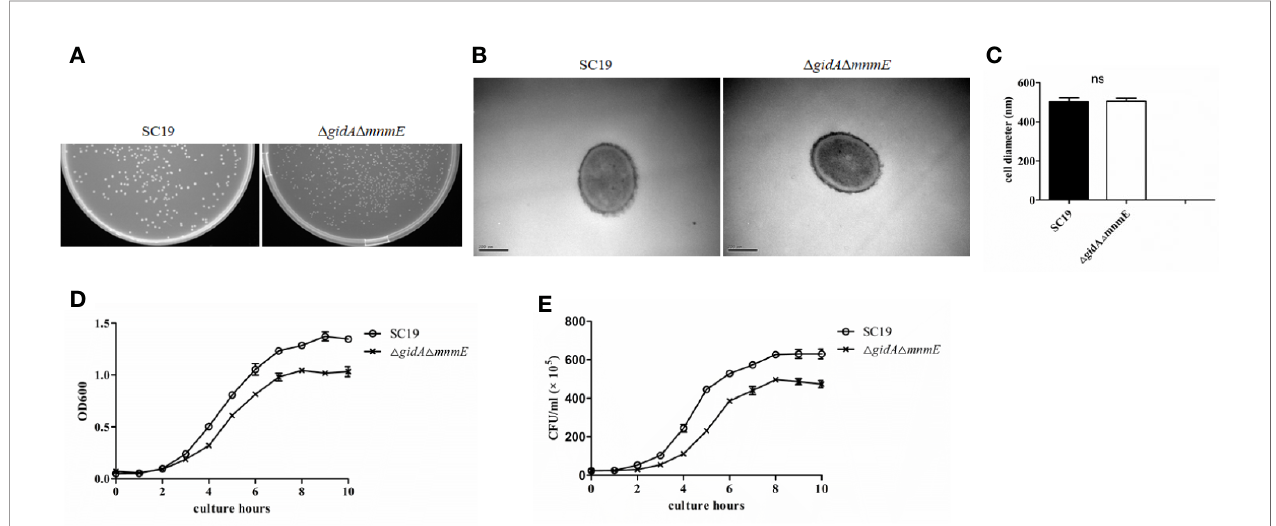
FIGURE 3 | Micrographs and growth characterization of SC19 and D gidA D mnmE . (A) Colonies of SC19 and D gidA D mnmE cultured overnight on THA plates. (B) Transmission electron microscopy micrographs of the strains. (C) Quanti fi cation of transmission electron microscopy (TEM) analysis of cell size. (D) Growth curves of the strains. Bacterial cell density was measured spectrometrically at 600 nm. Data were collected at the indicated times. (E) Colony-forming unit (CFU) count of the strains. Separate aliquots of the bacterial suspensions were serially diluted and plated to determine CFU numbers per milliliter. Data were collected at the indicated